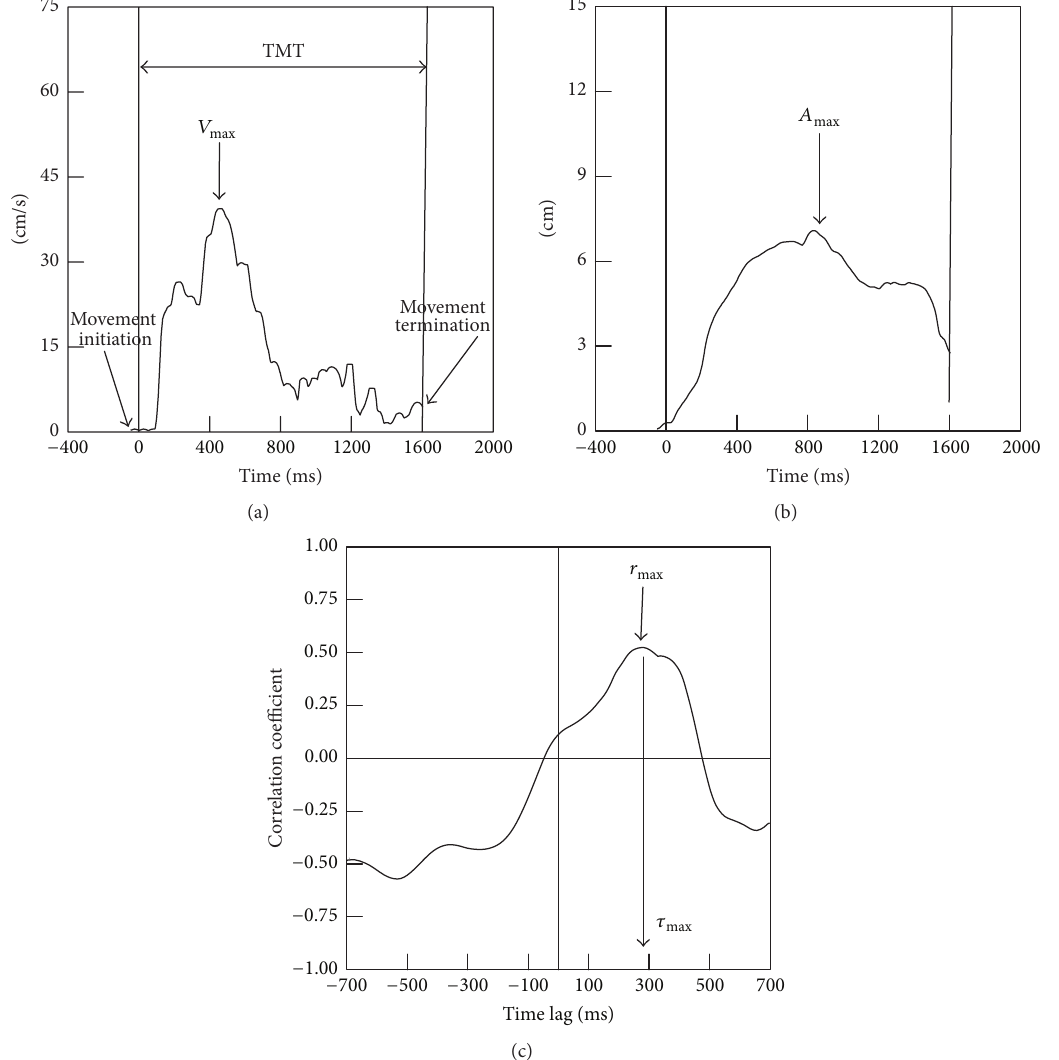
Figure 1: Key variables: (a) transport velocity with marked total movement time (TMT) and maximum transport velocity ( 𝑉 max ), (b) grasp aperture with marked maximum grasp aperture ( 𝐴 max ), and (c) transport-grasp coordination indicated by highest cross-correlation coefficient (upper arrow, 𝑟 max ) and associated time lag (lower arrow, 𝜏 max